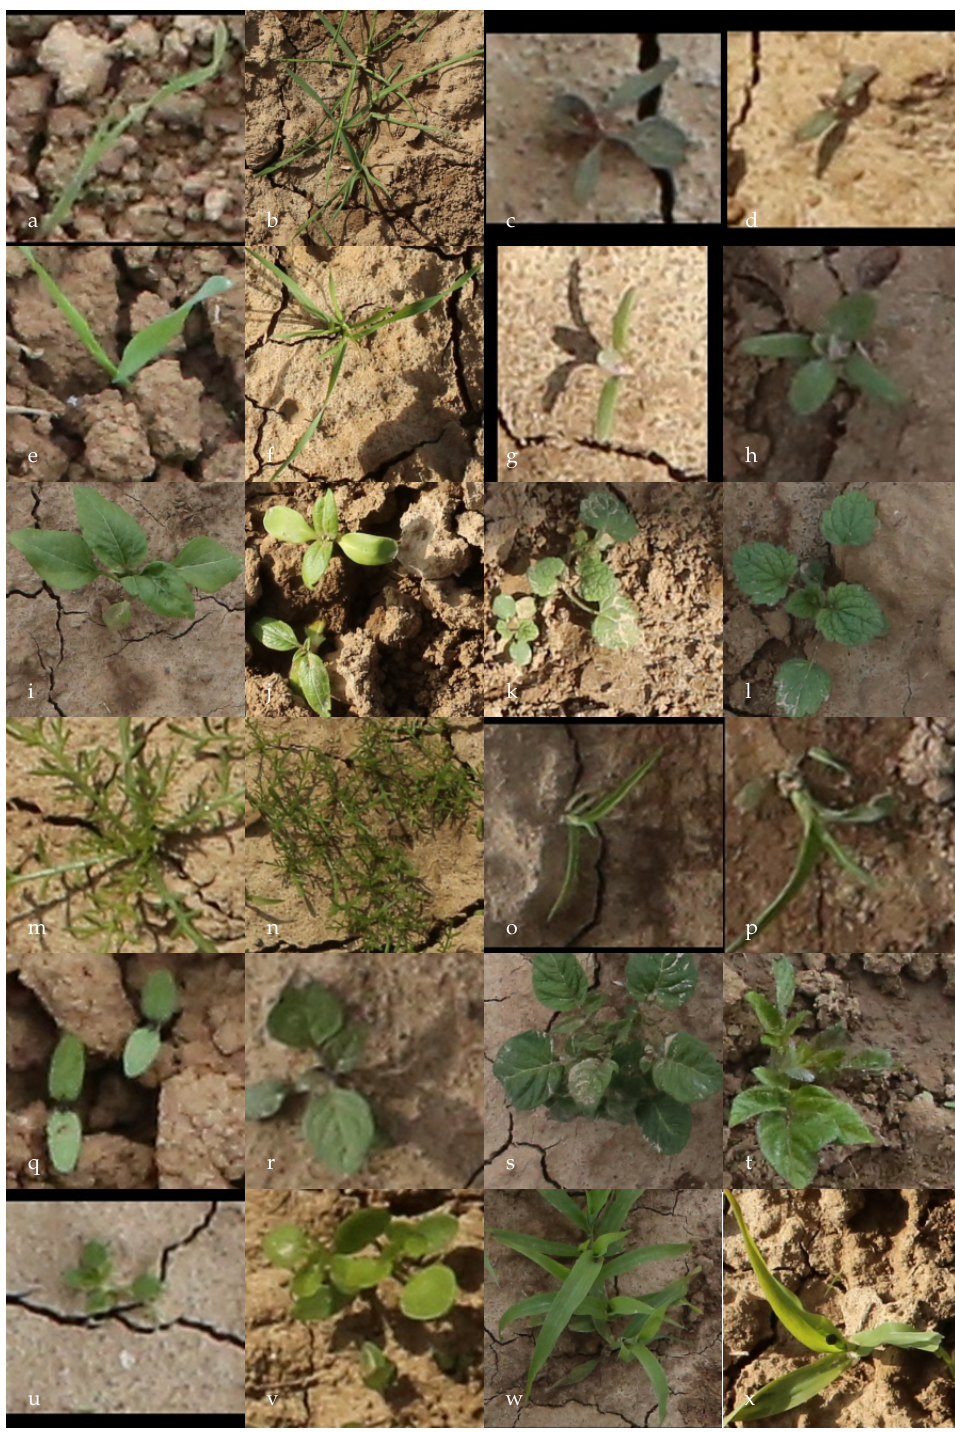
Figure 2. Some crop and weed images that were used for the training of the network. ( a , b ) Alopecurus myosuroides , ( c , d ) Amaranthus retroflexus , ( e , f ) Avena fatua , ( g , h ) Chenopodium album , ( i , j ) Helianthus annuus , ( k , l ) Lamium purpureum , ( m , n ) Matricaria chamomila , ( o , p ) Setaria spp., ( q , r ) Solanum nigrum , ( s , t ) Solanum tuberosum , ( u , v ) Stellaria media , ( w , x ) Zea mays